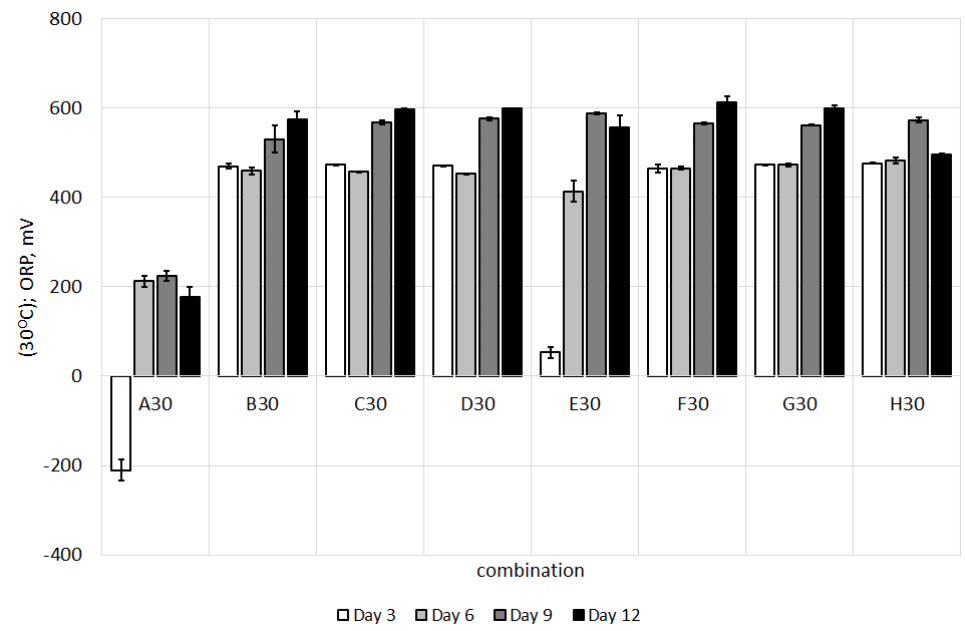
Figure 5. Oxidation reduction potential (ORP) of samples incubated at 30 °C.